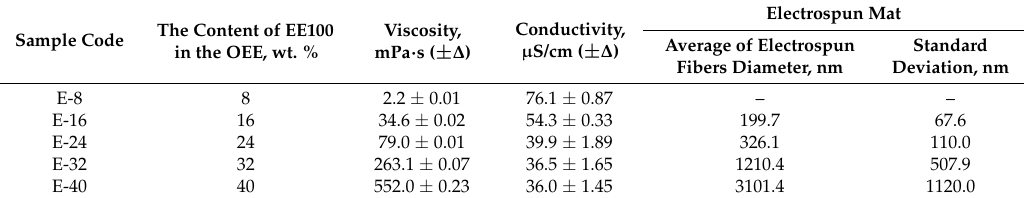
Table 1. Influence of amount of EE100 in the OEE on the solution viscosity, the conductivity and the diameter of electrospun fibers.